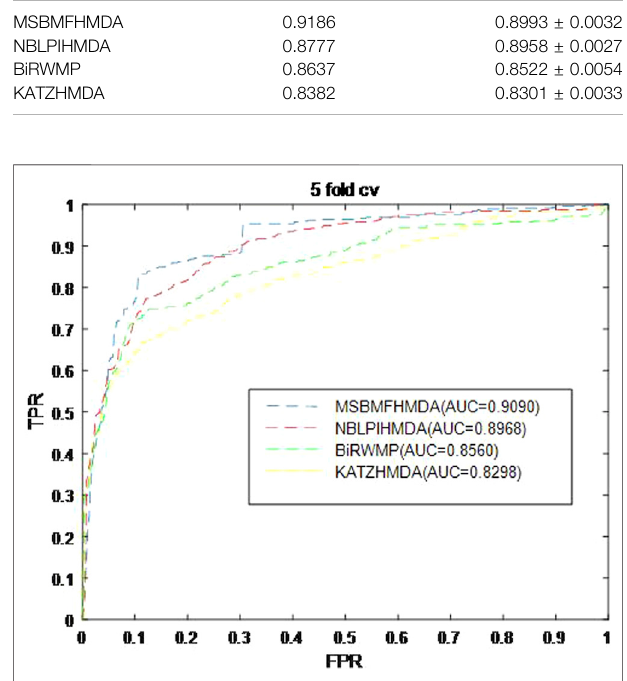
FIGURE 3 | Prediction performance comparison between MSBMFHMDA and the other three methods in fi vefold cross validation.